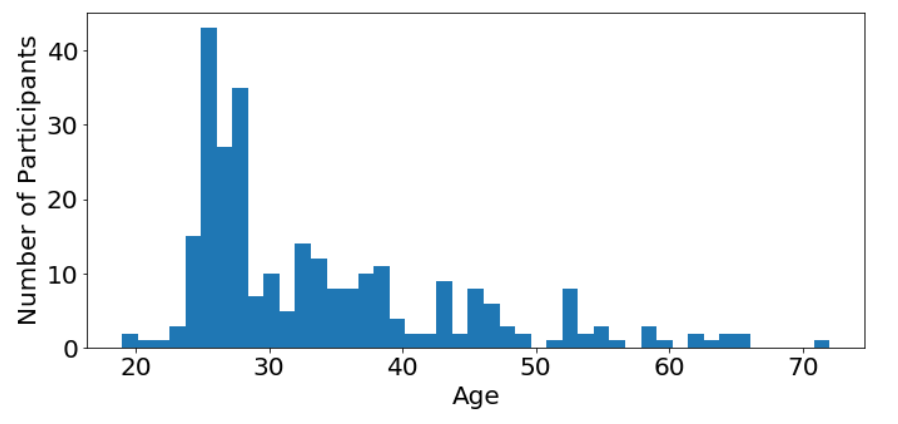
Figure 4. Age of